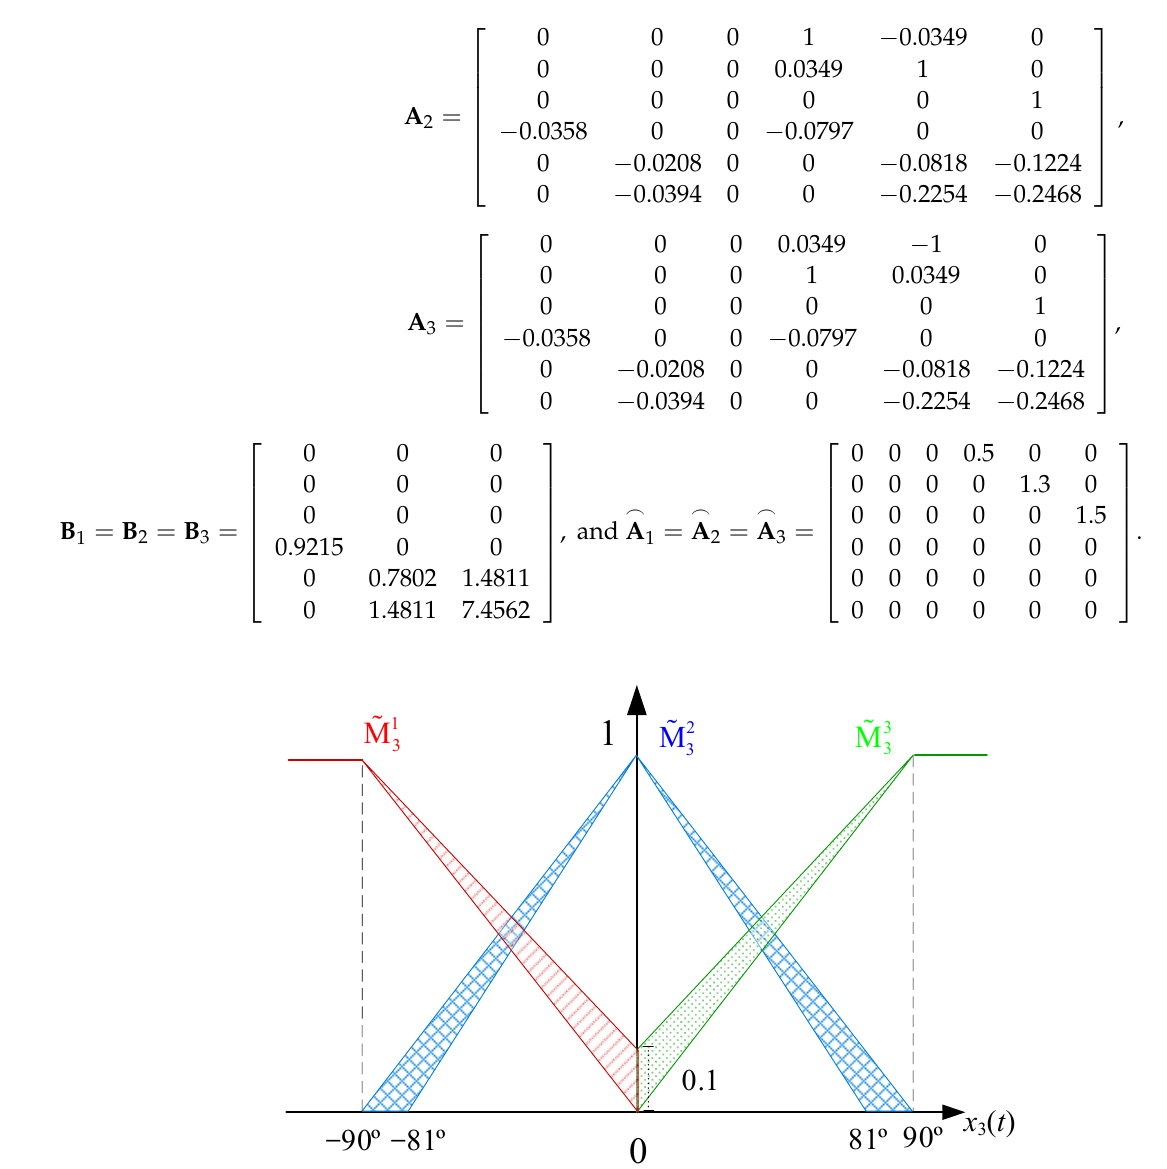
Figure 2. Membership functions of x 3 ( t )